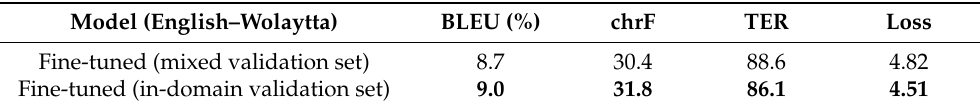
Table 9. BLEU, chrF, and TER scores of NMT models fine-tuned in authentic dataset for English– Wolaytta